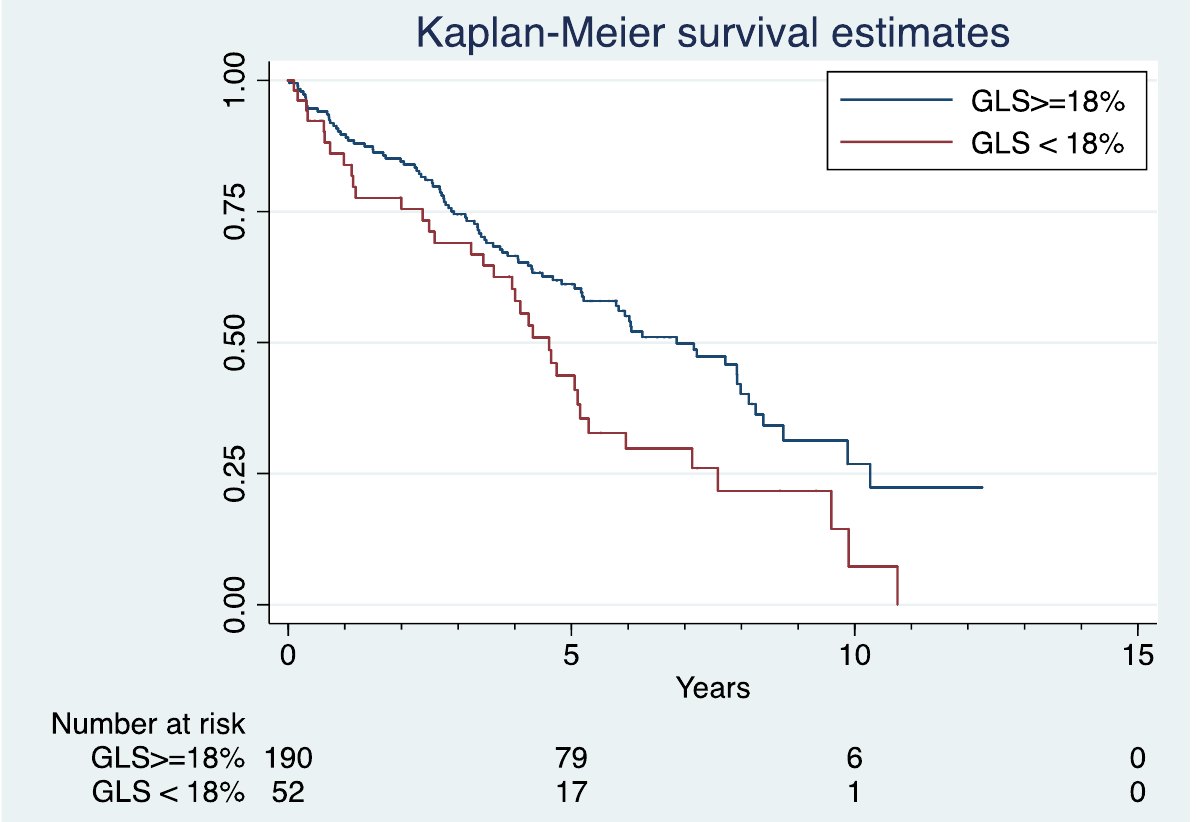
Figure 2. Global longitudinal strain and overall survival. Kaplan–Meier curves showing cumulative risk of all-cause mortality stratified by global longitudinal strain (GLS). Log-rank: p < 0.001.